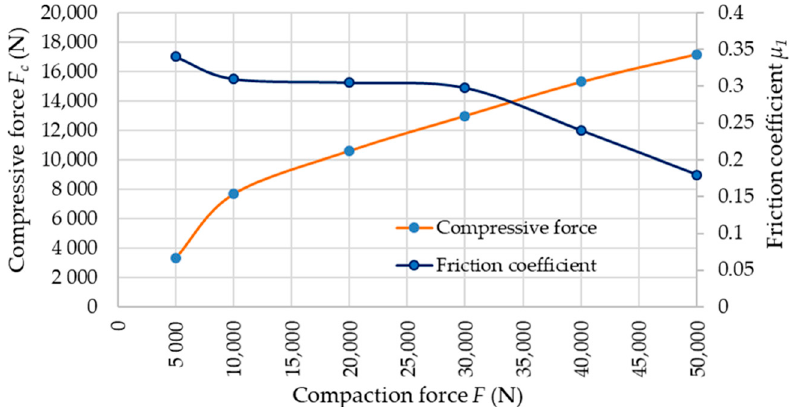
Figure 9. The characteristics of variance in the compressive force F c for the oak sawdust sample, and the values of the coefficient of friction µ 1 as a function of the compaction force F. Table 1. Breakdown of the optimization criteria for the compaction process parameters considering the compaction force F , coefficient of friction µ 1 and the characteristics of the obtained briquette expressed as the force F c .